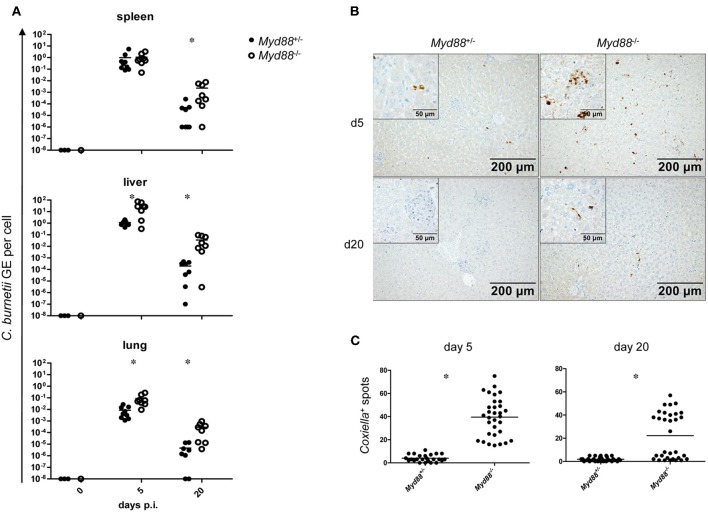
Increased bacterial load in Myd88−/− mice after intraperitoneal infection. Mice were infected i.p. with 5 × 107 CFU NMII and sacrificed after 5 and 20 days. (A) bacterial burden in spleen, liver and lung was assessed by qPCR for the C. burnetii insertion sequence IS1111 and for the murine albumin gene. Shown are NMII GE per cell. Each dot in the graphs represents one single mouse; data were pooled from two independent experiment. (B) immunohistochemical staining of liver sections with anti-C. burnetii antiserum shown at 100x magnification. (Inset) enlarged view at 400x magnification. (C) quantitation of Coxiella-containing cells (dark spots) per field of view at 100x magnification was performed for eight randomly chosen positions on sections from 4 individual mice per condition. Results were analyzed using an unpaired two-tailed Mann-Whitney U test.